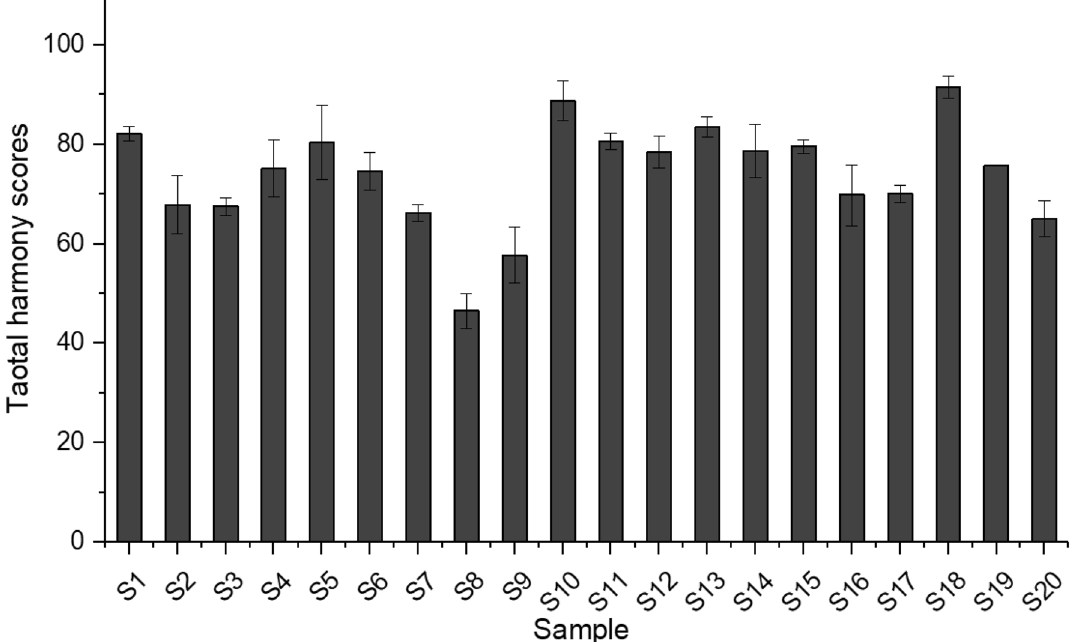
Figure 1. The total harmony scores of all the flue-cured tobacco leaves